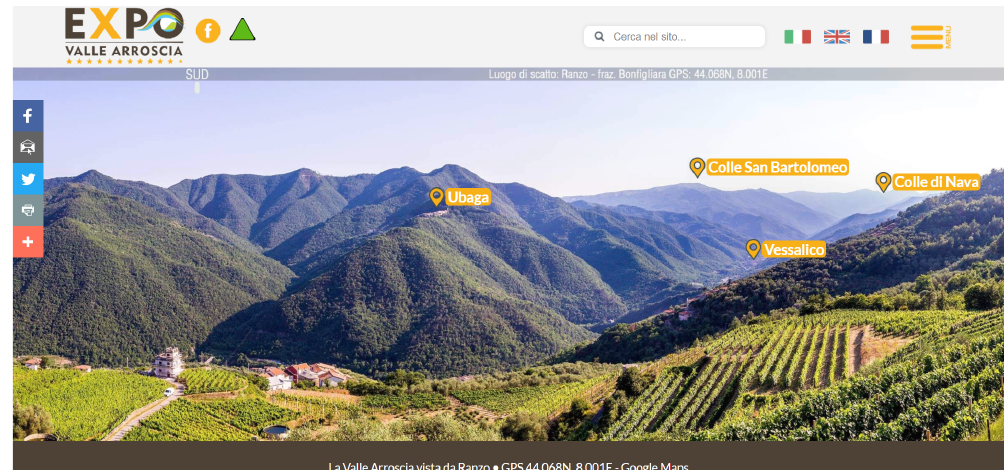
Fig. 5 The panoramic view in the Expo Valle Arroscia